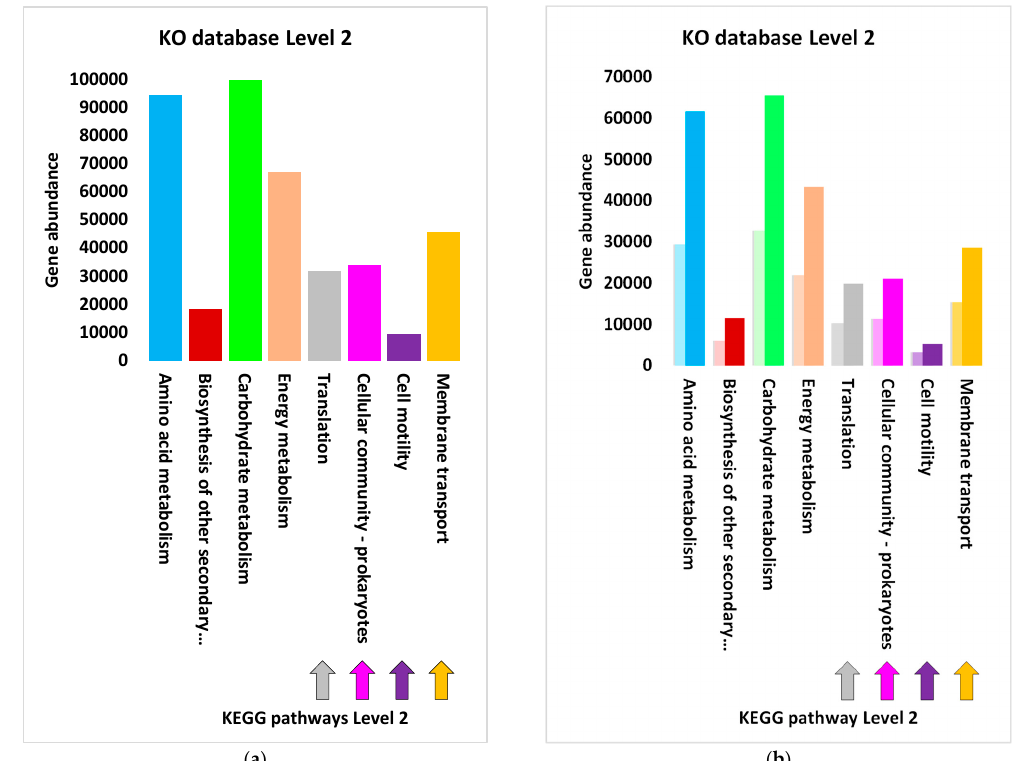
Figure 3. Abundance of genes encoding enzymes of the different functional sub ‐ categories of KEGG database Level 2 across ( a ) and between ( b ) samples of rhizosphere (R) and surrounding bulk soil (S) microbiomes of M. oleifera . Columns with dark colors in ( b ) refer to rhizosphere (R) soil microbi ‐ ome, while those with light colors refer to microbiome of the surrounding bulk (S) soil. All KEGG sub ‐ categories belong to the category “Metabolism”, except for the last four sub ‐ categories that be ‐ long to categories “Genetic Information Processing” (indicated by the gray arrow), “Cellular Pro ‐ cesses” (indicated by the dark pink and violet arrows), and “Environmental Information Pro ‐ cessing” (indicated by the orange arrow). The data in ( b ) is further described in Figure S3, while detailed abundance records in ( a ) and ( b ) are shown in Tables S6 and S9, respectively. Same column color in (a) and (b) represents same KEGG category. Gene abundance across and between soil microbiome types for 21 selected KEGG pathways from the eight sub ‐ categories are shown in Figures 4a and b. Nine of these path ‐ ways referring to soil type microbiomes are displayed in Figure S5. The results indicated that the abundance of genes in the rhizosphere microbiome at the level of pathways for